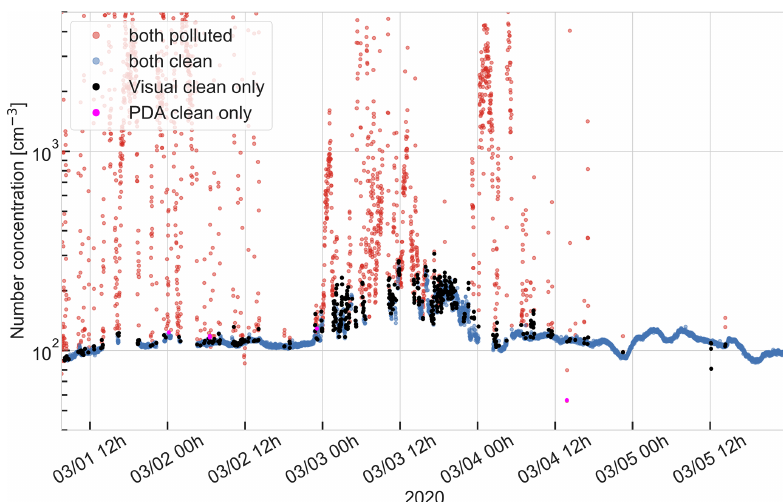
Figure A8. Time series with a comparison of the visual identification method and the PDA between 1 and 5 March. In red: data points which are detected as contaminated by both methods. In blue: data points which are detected as unaffected by pollution by both methods. In black: data points which are detected as unaffected by pollution only by the visual identification method. In magenta: data points which are detected as pollution free only by the